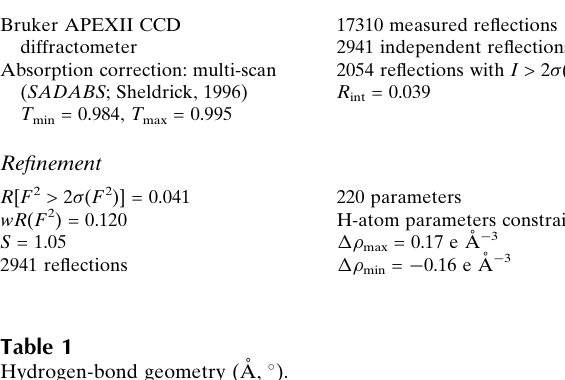
Hydrogen-bond geometry (A˚ , (cid:1)